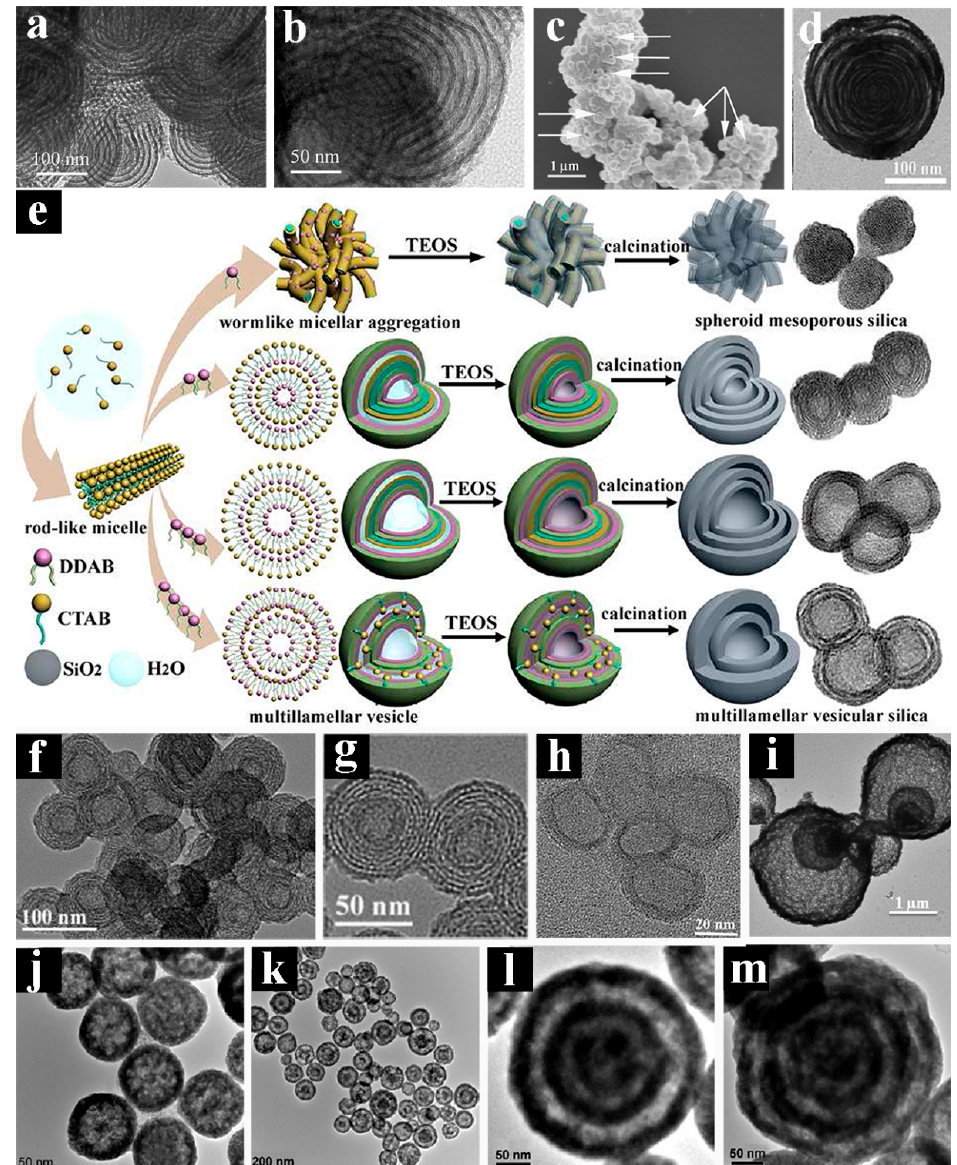
Figure 8. Schematic demonstration and graphical illustration of multi–shells structure synthesized by soft-templating method: ( a , b ) high resolution transmission electron microscopy (HRTEM) and ( c ) field-emission SEM (FESEM) images of silica (SiO 2 ) multi-shelled hollow spheres (MSHSs). ( d ) transmission electron microscopy (TEM) image of the SiO 2 MSHSs. ( e ) Schematic representation of the proposed assembly mechanism for the preparation of the SiO 2 MSHSs, ( f and g ) HRTEM images of the SiO 2 MSHSs. ( h ) TEM image of the PANI MSHSs. ( i ) TEM image of CoFe 2 O 4 QSHSs. TEM images of Cu 2 O ( j ) single-shelled hollow spheres (SSHSs), ( k ) double-shelled hollow spheres (DSHSs), ( l ) triple-shelled hollow spheres (TSHSs), and ( m ) quadruple-shelled hollow spheres (QSHSs). Pictures ( a ), ( b ), and ( c ) were reprinted with permission from Reference [135]. Copyright the Royal Society Chemistry, 2007. Picture ( d ) was reprinted with permission from Reference [136]. Copyright Elsevier, 2012. Pictures ( e ), ( f ), and ( g ) were reprinted with permission from Reference [137]. Copyright the Royal Society Chemistry, 2014. Picture ( h ) was reprinted with permission from Reference [138]. Copyright Springer, 2016. Picture ( i ) was reprinted with permission from Reference [139]. Copyright Springer, 2016. Pictures ( j ), ( k ), ( l ), and ( m ) were reprinted with permission from Reference [119]. Copyright Wiley,